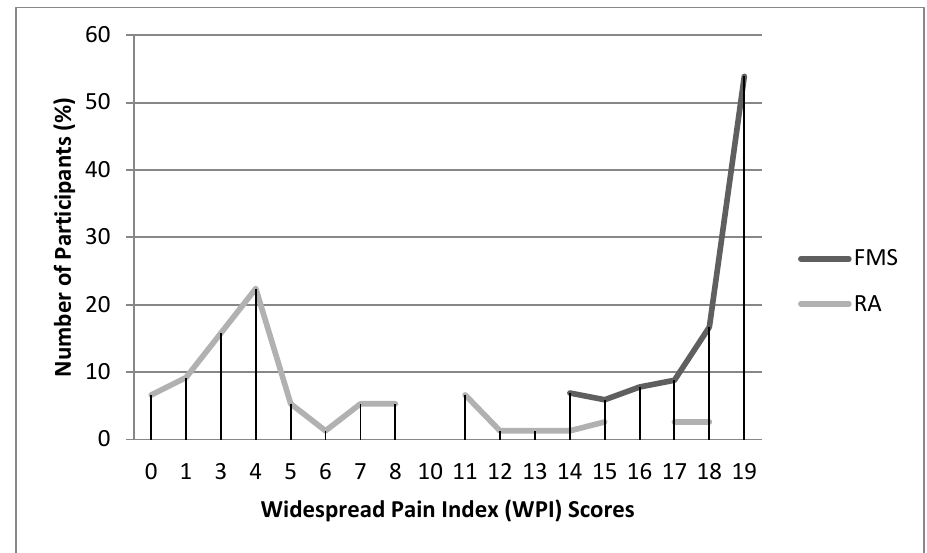
Figure 1. Distribution of Widespread Pain Index (WPI) scores in Fibromyalgia syndrome (FMS) and rheumatoid arthritis (RA) patients.